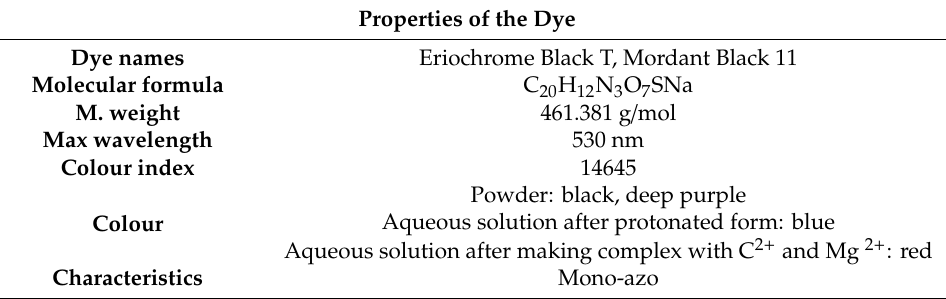
Table 1. Characteristics of Eriochrome Black T (EBT)